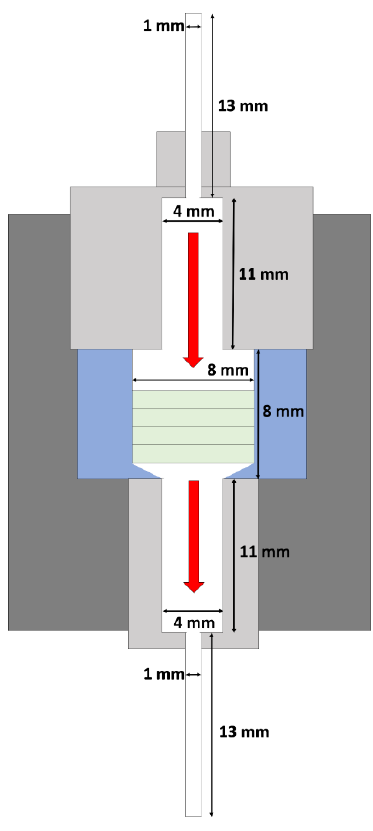
Figure 1. Cross-sectional view of the bioreactor.